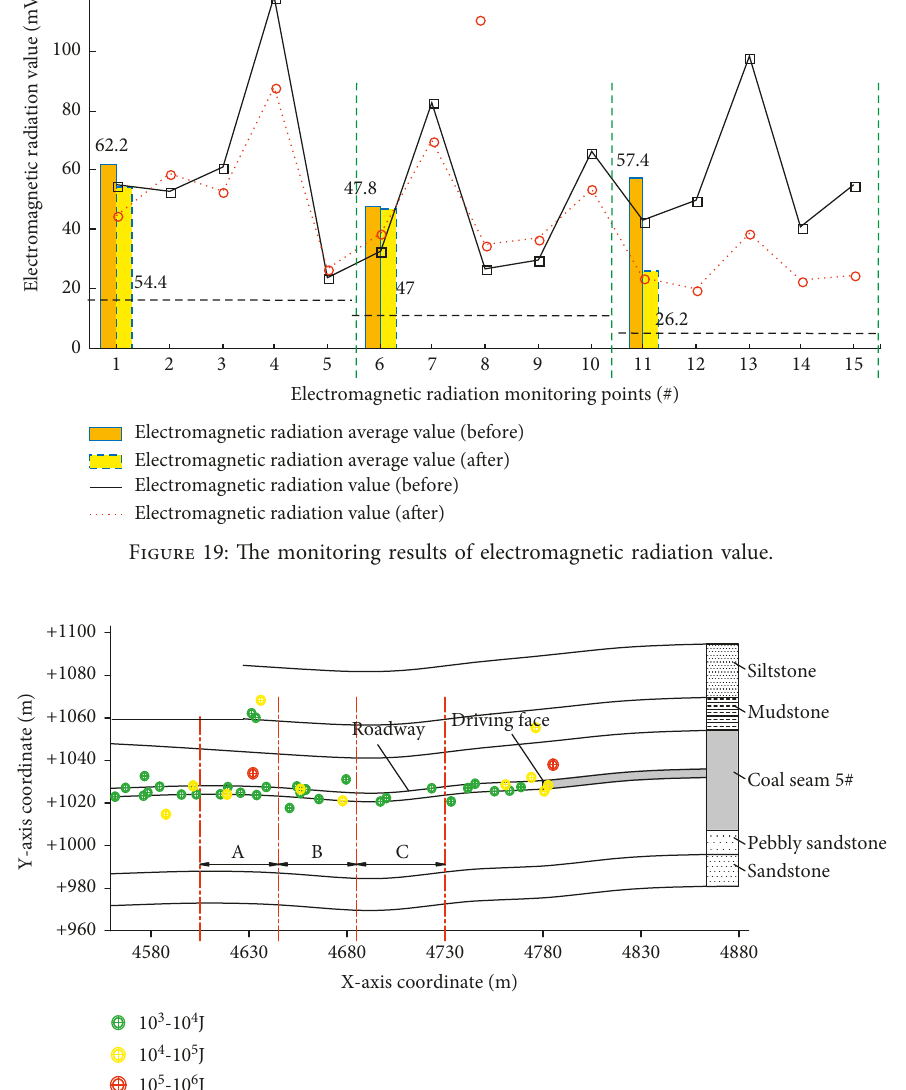
Figure 20: The monitoring results of energy level of microseismic